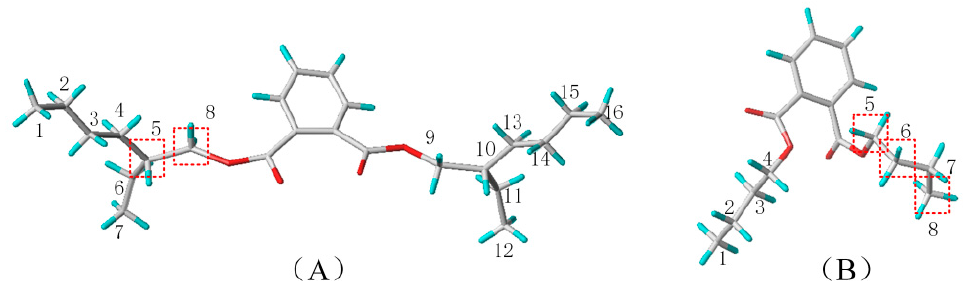
Figure 1. Schematic diagram of the stereological structure and modification sites of DEHP ( A ) and DBP ( B ) molecules.